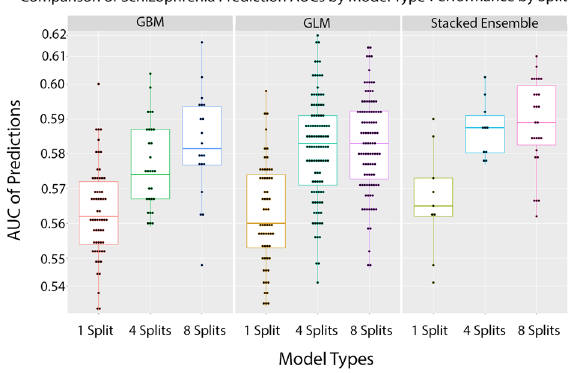
Figure 2. We tested whether finer splits of each chromosome lead to better predictability. We split each chromosome into either one, four, or eight subsections. We computed the chromosome scale length variation for each of these subsections for each person. This set of numbers was used to predict whether patients had schizophrenia. The quality of this prediction was characterized by the AUC. This plot demonstrates how the quality of these predictions increase with finer information on chromosome length variation. The Stacked Ensemble algorithm performs the best across all split variations.